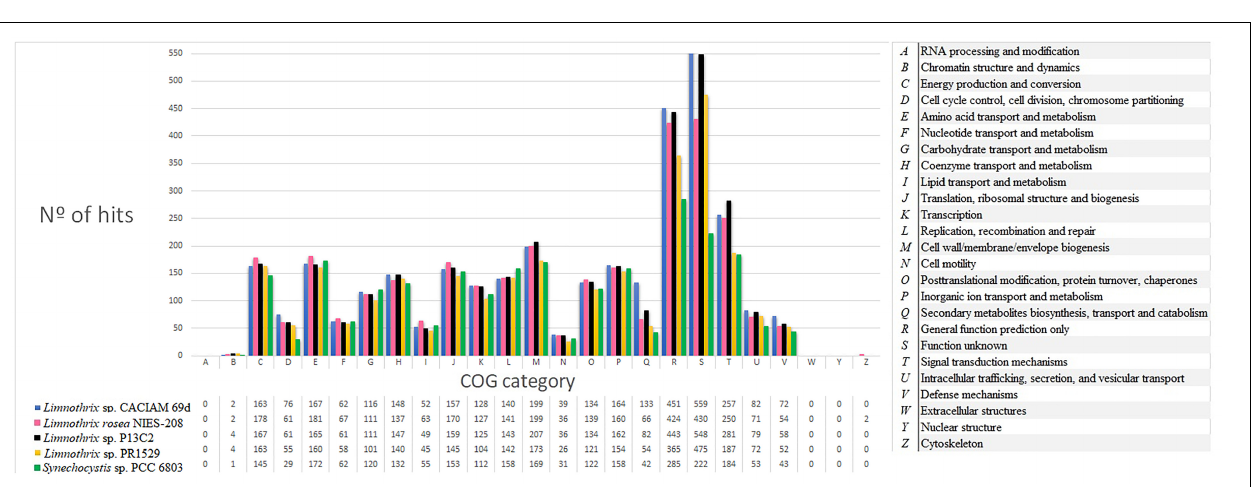
FIGURE 5 | Number of hits per COG category for all four Limnothrix genomes and Synechocystis sp. PCC 6803.